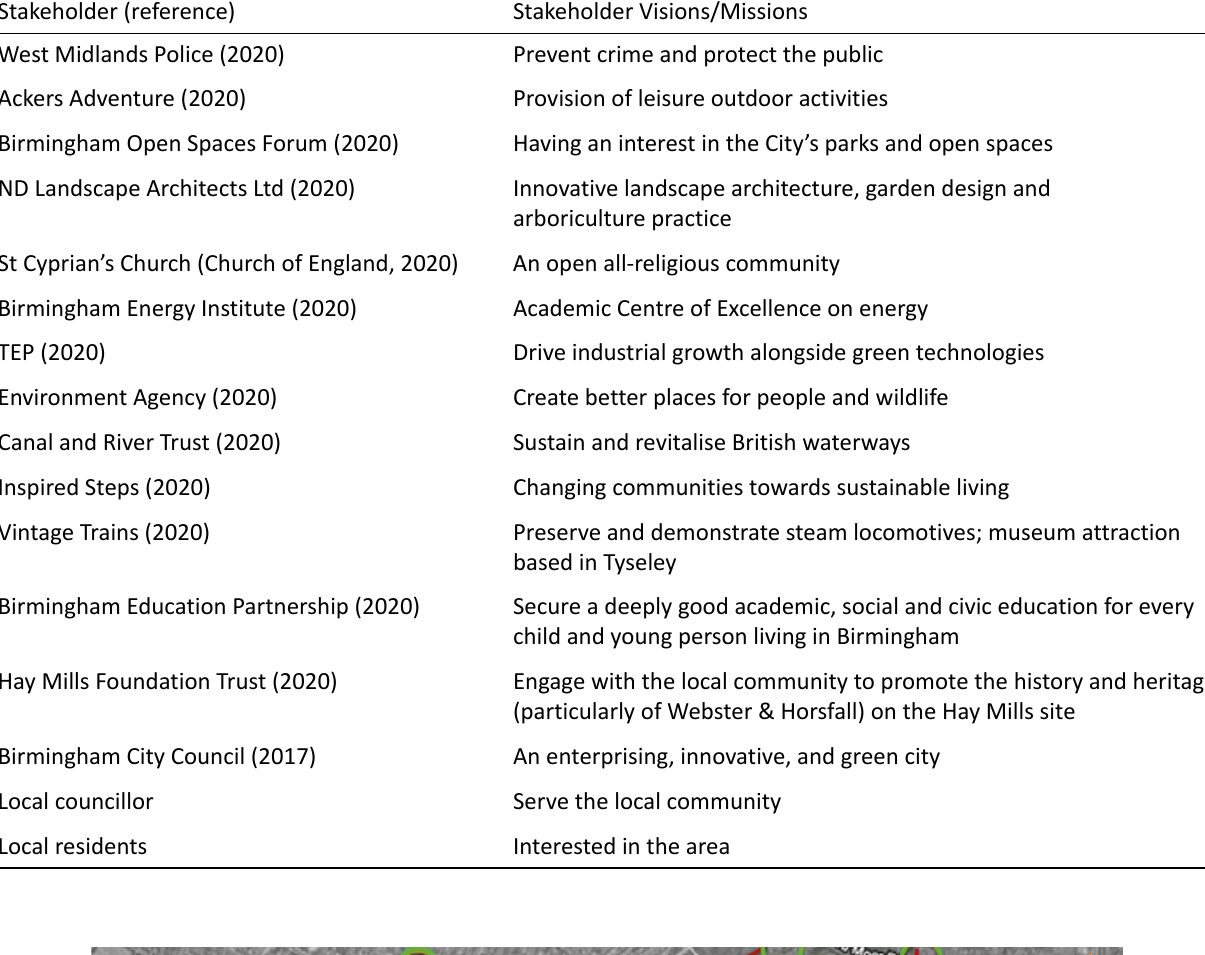
Table 2. The Lost World stakeholders and their visions/missions.